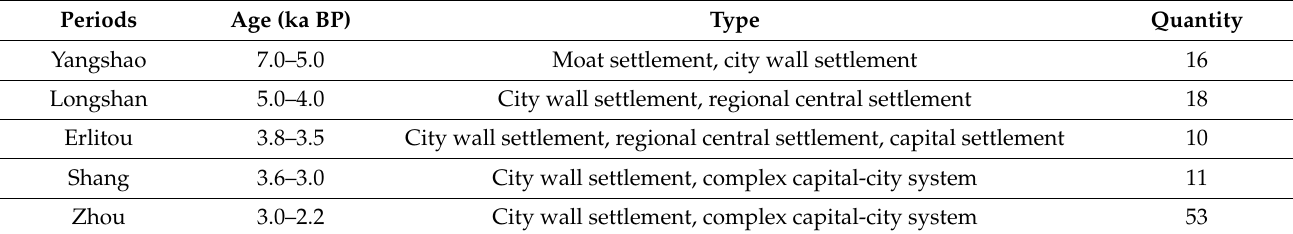
Figure 2. The images of some early cities in the Songshan region. ( a ) The triple moat system of the Shuanghuaishu site which is considered a regional central settlement of the late Yangshao period (5300–5000 BP) [42]; ( b ) the regional earliest city walls in the Xishan site [43]. The image is from ESRI. ( c ) Most city walls of the Guchengzhai site of the late Longshan culture (4000 BP) are still standing on the ground. ( d ) There are triple city walls in the Zhengzhou Shang City which is the capital of early Shang Dynasty (3600–3300 BP) [44]. The existing city walls are marked in green. ( e ) The Jingxiang city is a feudal state of Zheng State which is also a feudal princedom of East Zhou Dynasty (770–256 BC). The image is from MAP WORLD. Table 1. Neolithic-Bronze